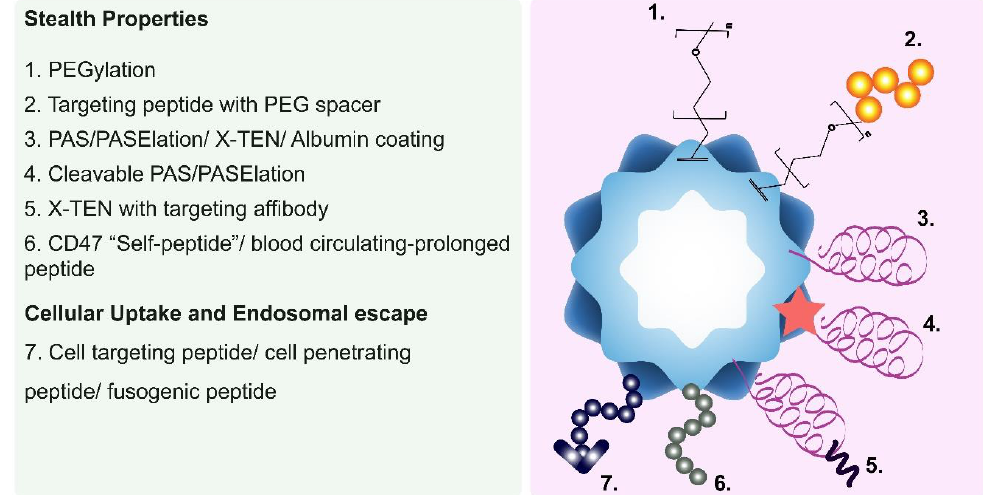
Figure 2. Illustration showing the various outer surface modifications used to make ‘stealth’ PNPs , and/or enhance their cellular targeting, uptake, and intracellular